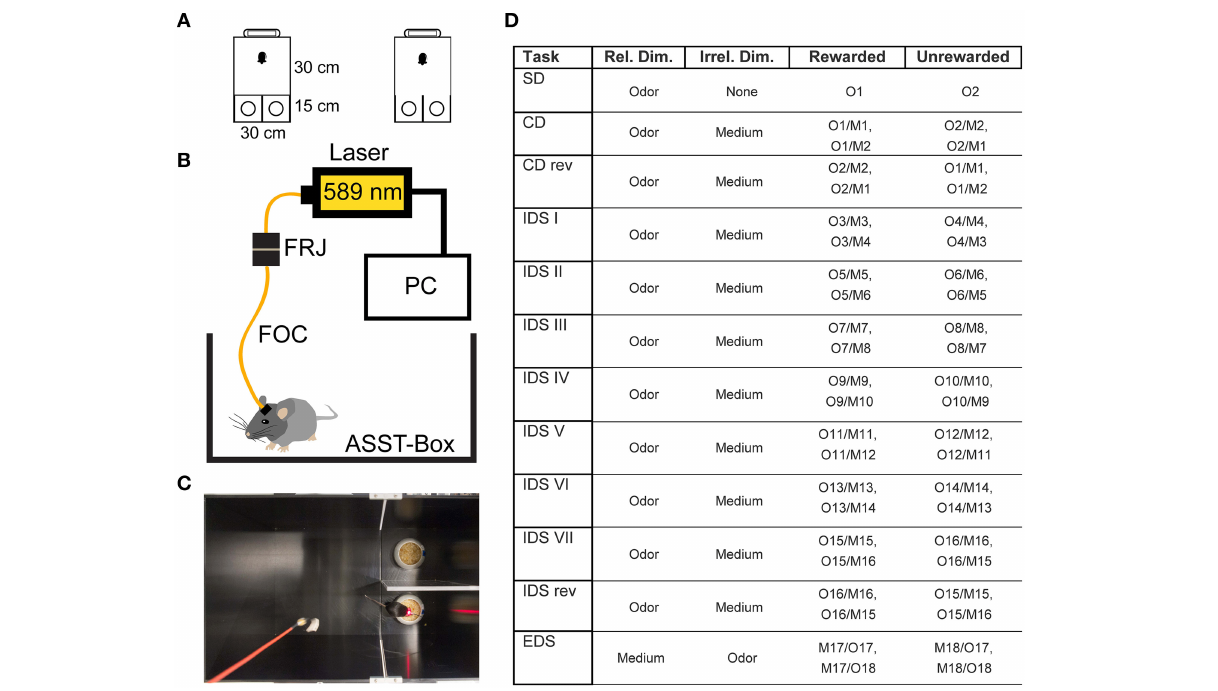
Frontiers in Behavioral Neuroscience |